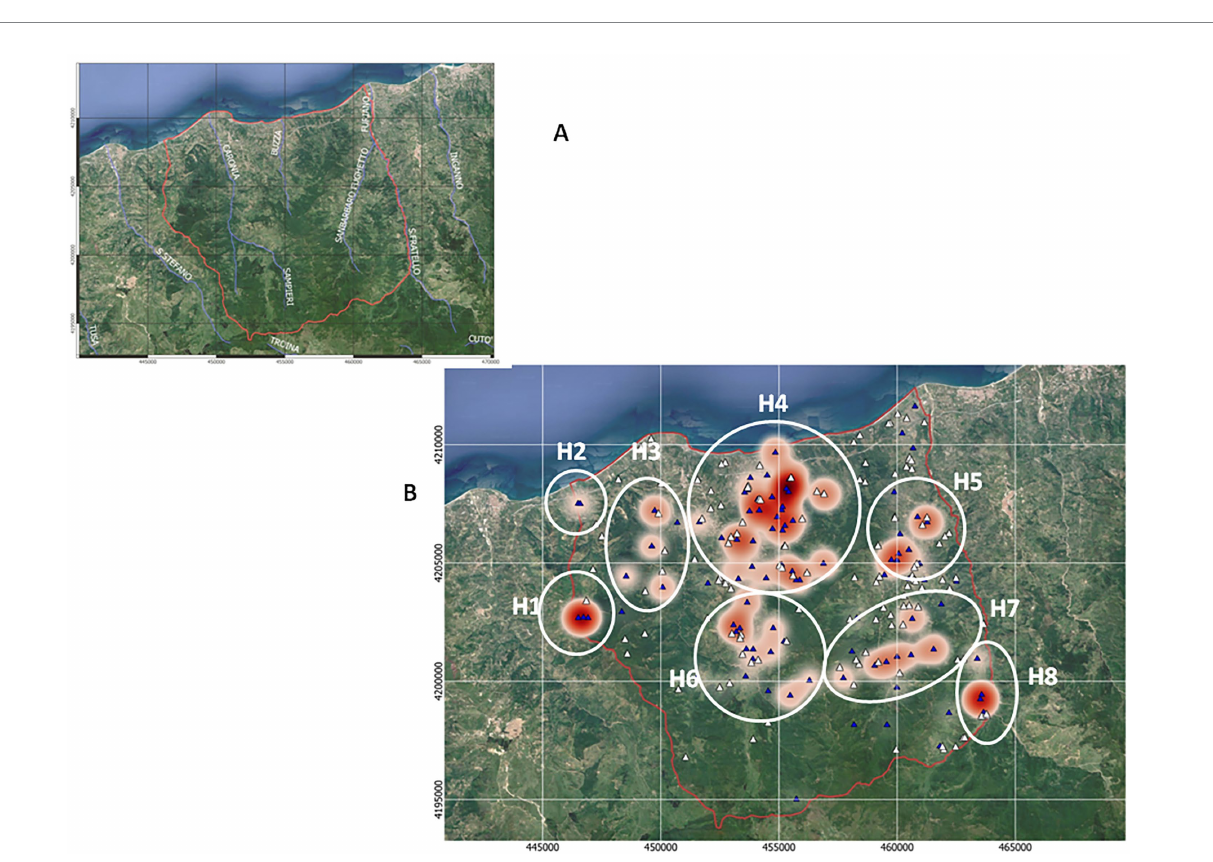
FIGURE 2 TB infections across the Caronia district. (A) The main streams flowing through the district—Caronia, Buzza, Sampieri, and San Barbaro. (B) Farms, both infected ( n = 107) and uninfected ( n = 129), are shown as blue and white triangles, respectively. Shades of red represent TB infections, where darker red represents a higher number of cases per herd. The eight geographical subareas of TB infection (H1–H8) are circled. The boundaries of the district of Caronia is indicated (the red line). Both maps were adapted from